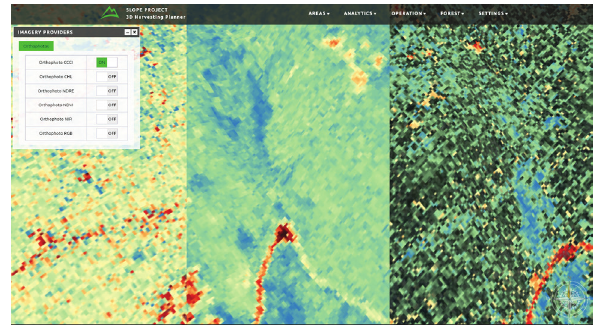
Figure 6. Satellite imageries evaluated under different indexes: CCCI, NDVI and NDRE